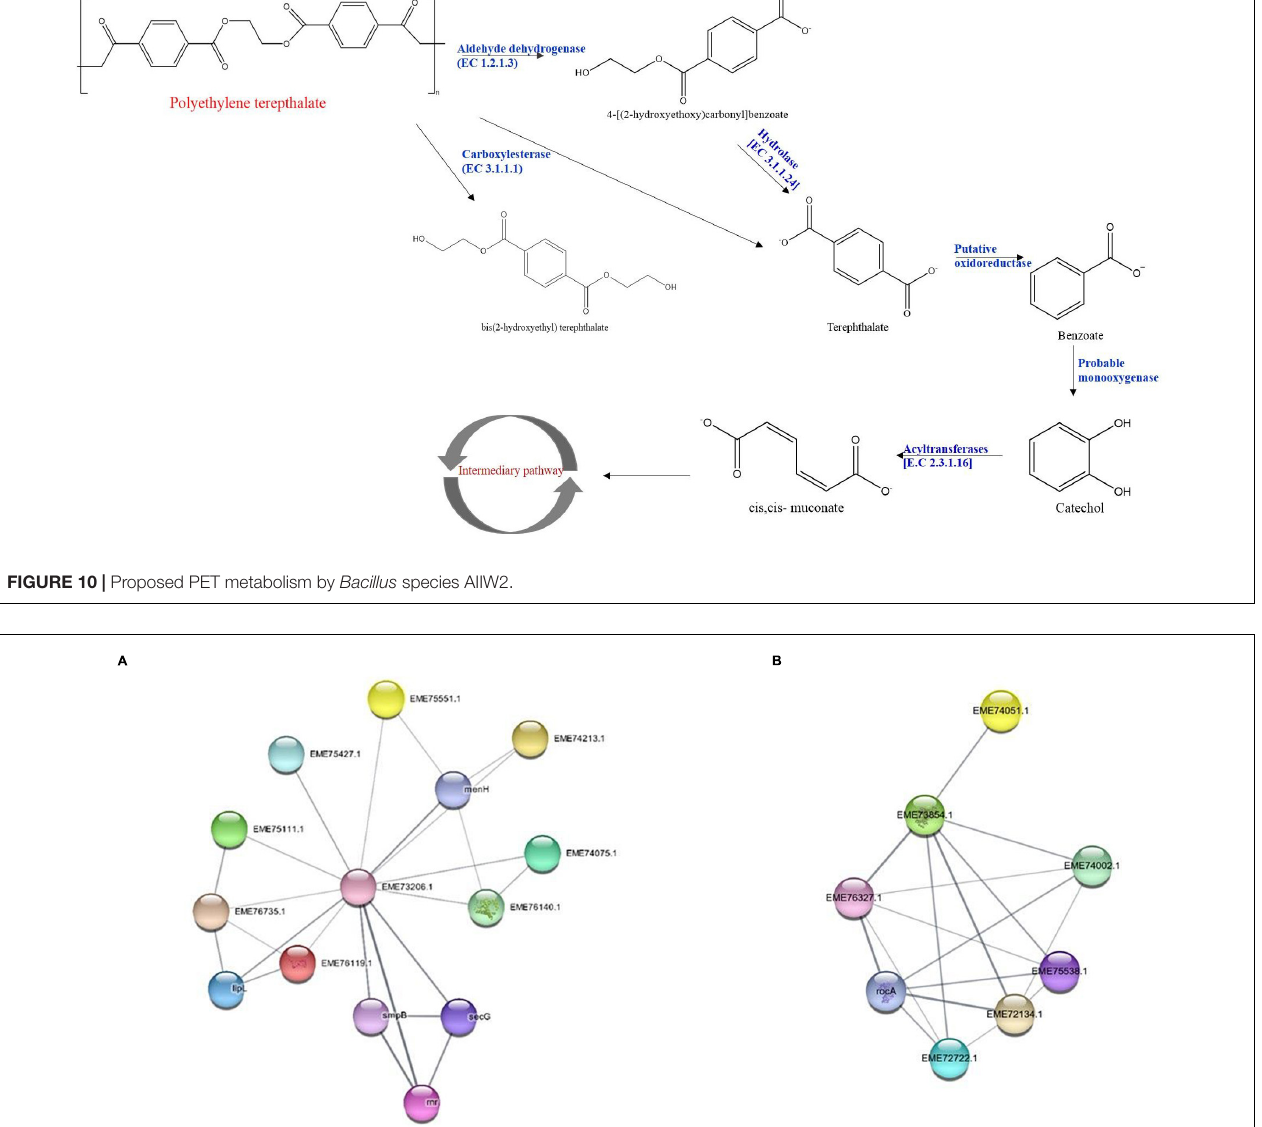
incubation with rhizospheric microbe in carbonyl bond